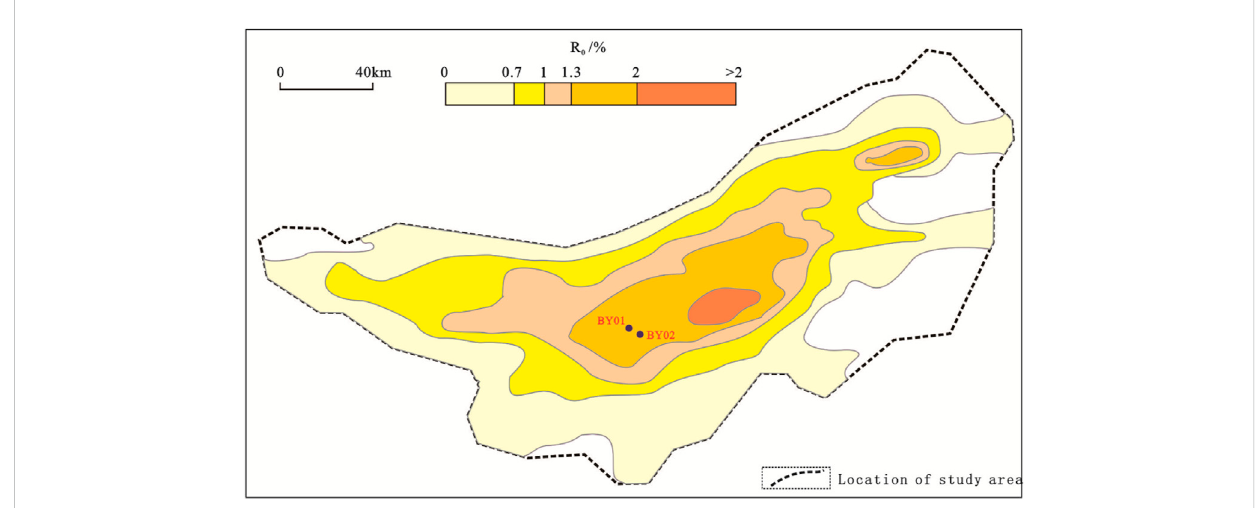
FIGURE 9 Contour map of maturity of organic matter in the Middle of Enping Formation, Baiyun Sag Mi et al., 2018.